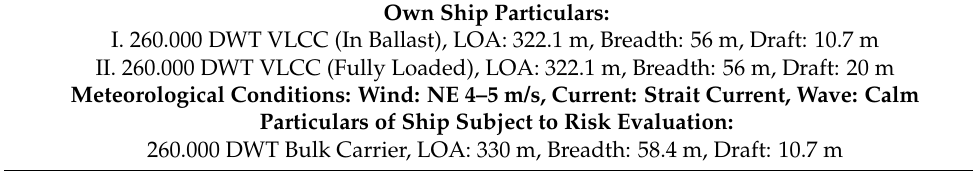
Table 2. Simulator exercises and summaries of scenarios. Own Ship